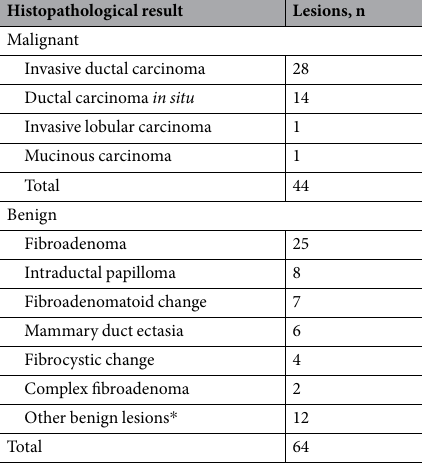
Table 1. Histopathological results of biopsied lesions. * Other benign lesions: pseudoangiomatous stromal hyperplasia, nodular adenosis, sclerosing papilloma, benign phyllodes tumour, post-mammotome change, suture granuloma, inflamed granulation tissue, foreign body and foreign body reaction, fibrous mastopathy, ruptured epidermal cyst, fibroadipose tissue, and no diagnostic